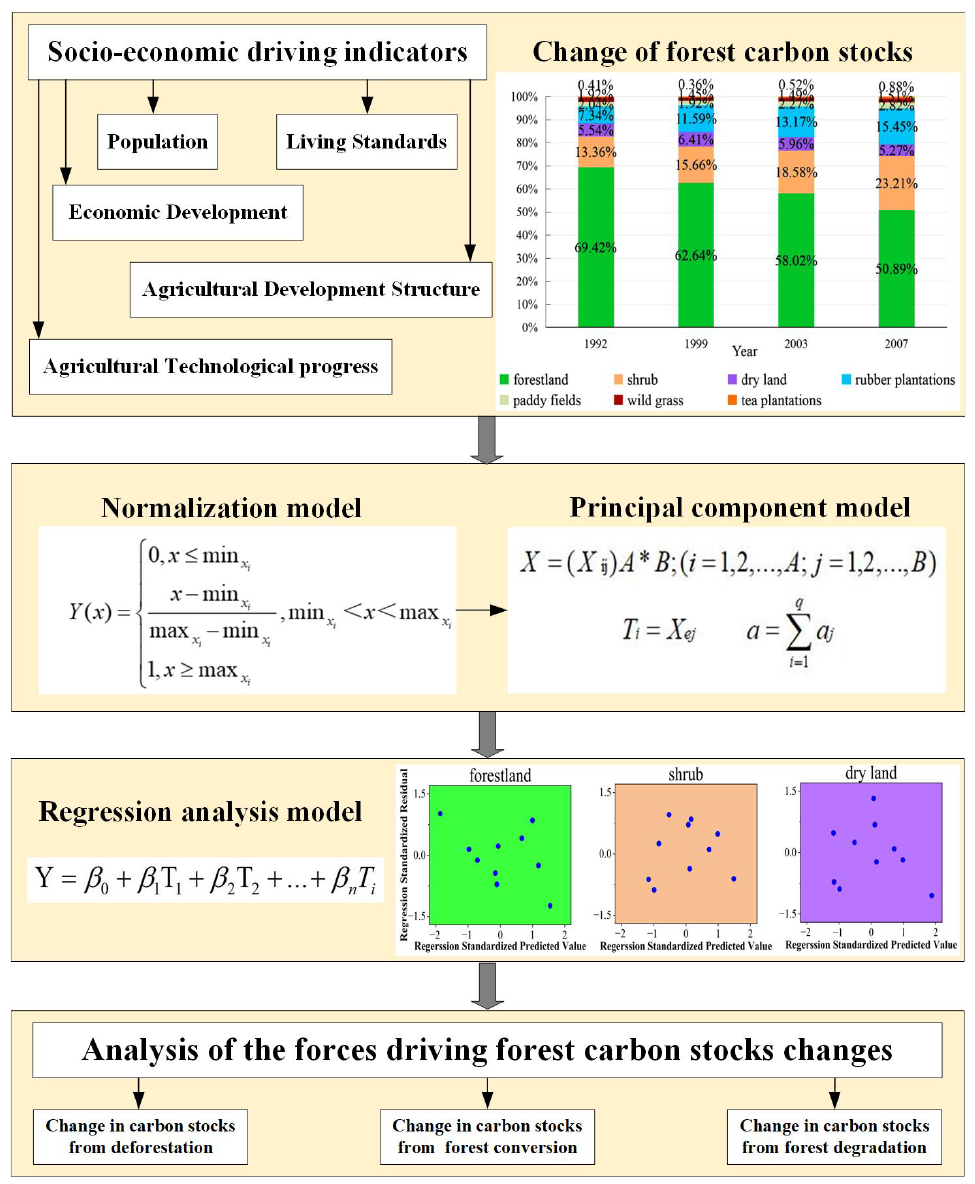
Figure 2. Methodological framework.